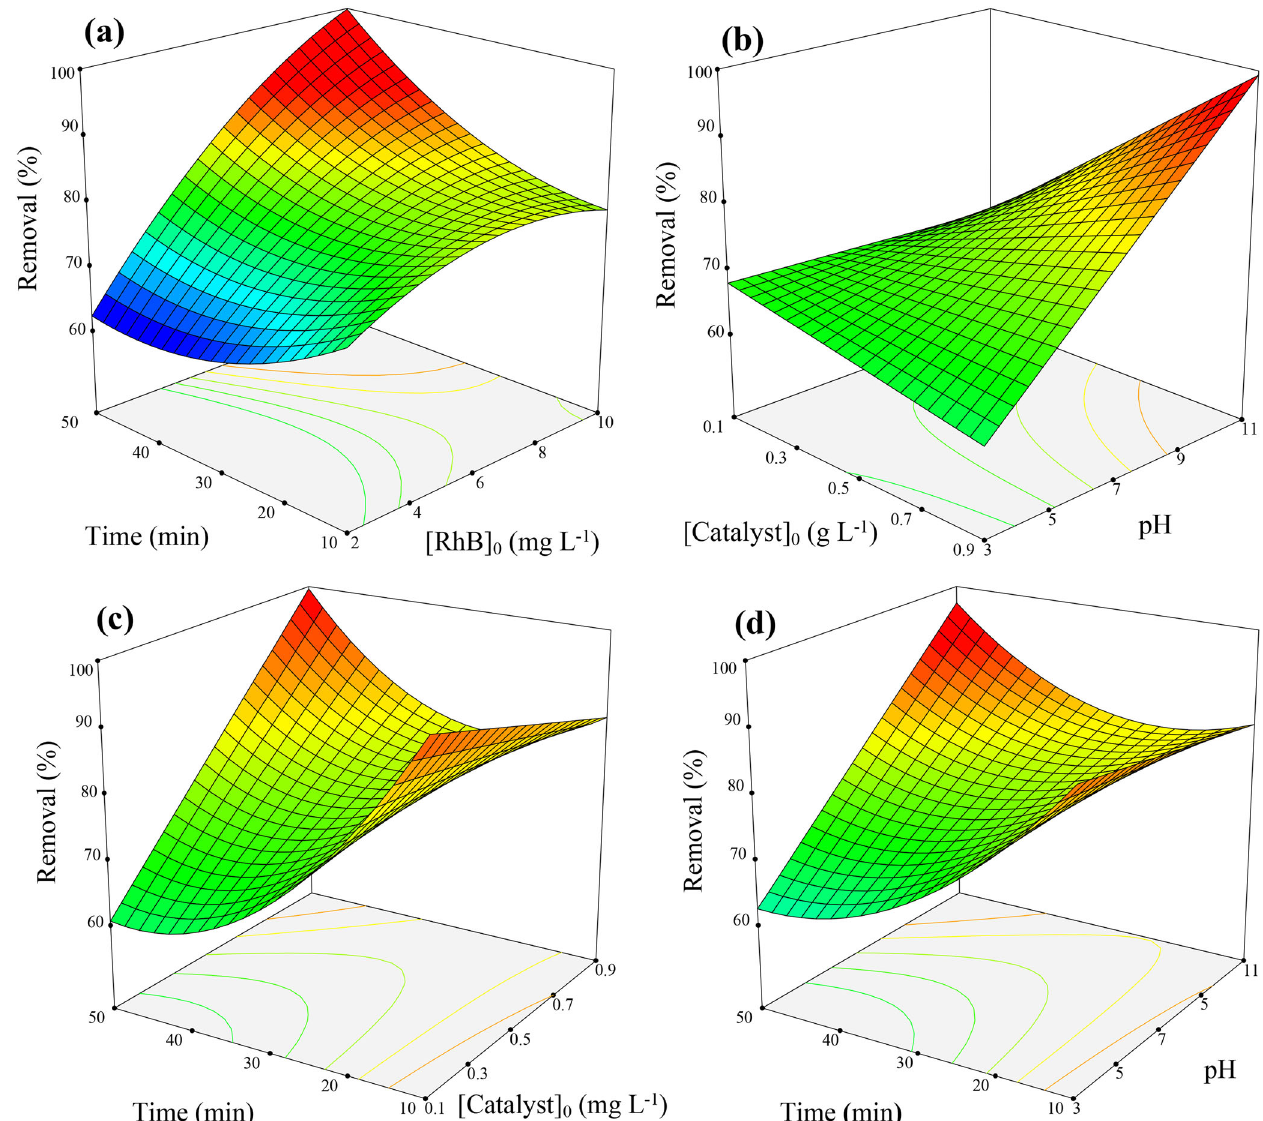
Fig. 7 Response surface plots of the RhB removal ef fi ciency. a irradiation time-initial RhB concentration. b catalyst dosage-pH. c irradiation time-catalyst dosage. d irradiation time-pH.